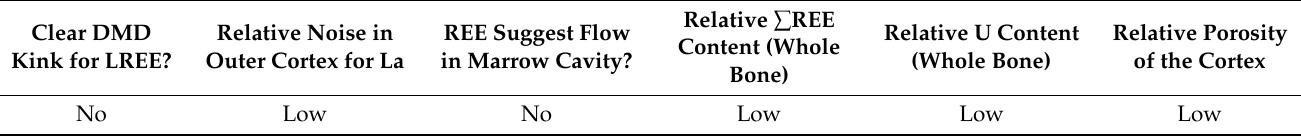
Table 2. Summary of the REE composition of the right femur of Tyrannosaurs rex MOR 1125. Qualitative ∑ REE content is based on the value shown in Table 1 (596 ppm) in comparison to values from other Mesozoic bones (as listed in the main text). Abbreviations: DMD—double medium diffusion sensu [44]; LREE—light rare earth